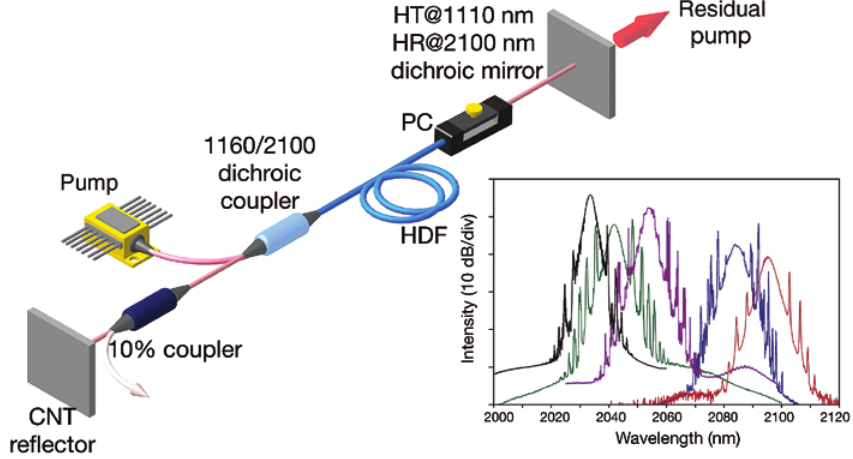
Figure 19: Schematic configuration of the Ho-doped fibre laser. HDF, Holmium-doped fibre; PC, polarisation controller. Inset: Tunability of the mode-locked Ho-doped fibre laser. Adapted from